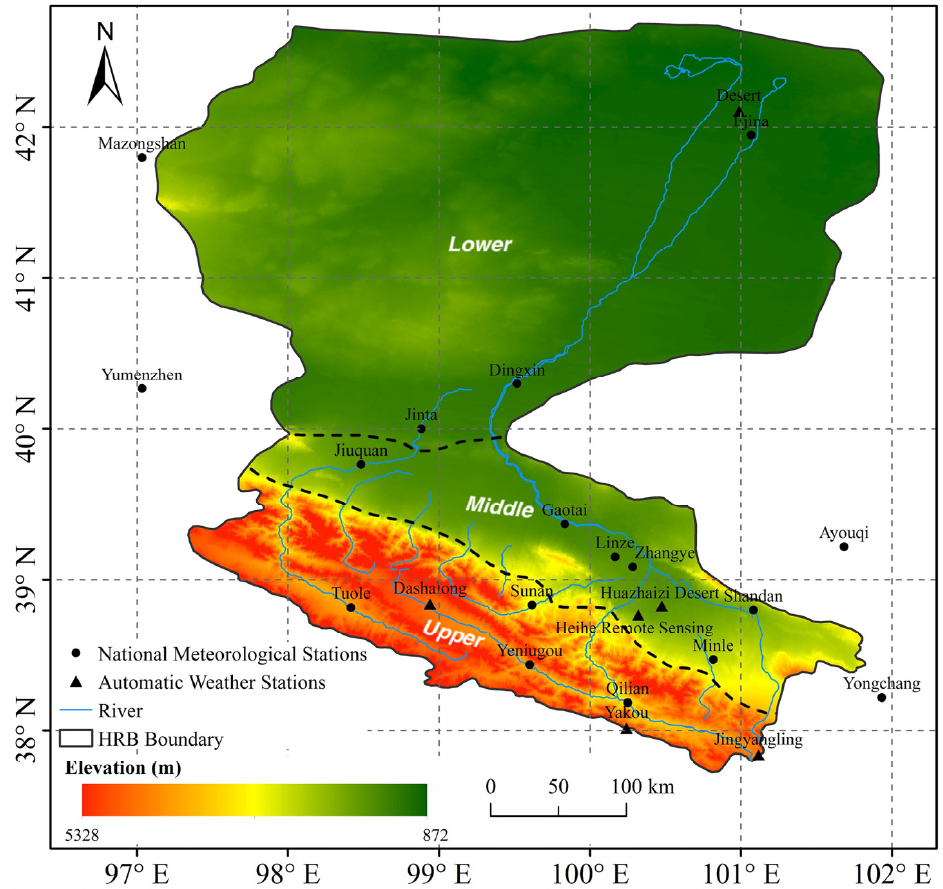
Figure 1. Topography and station distribution map over the HRB.